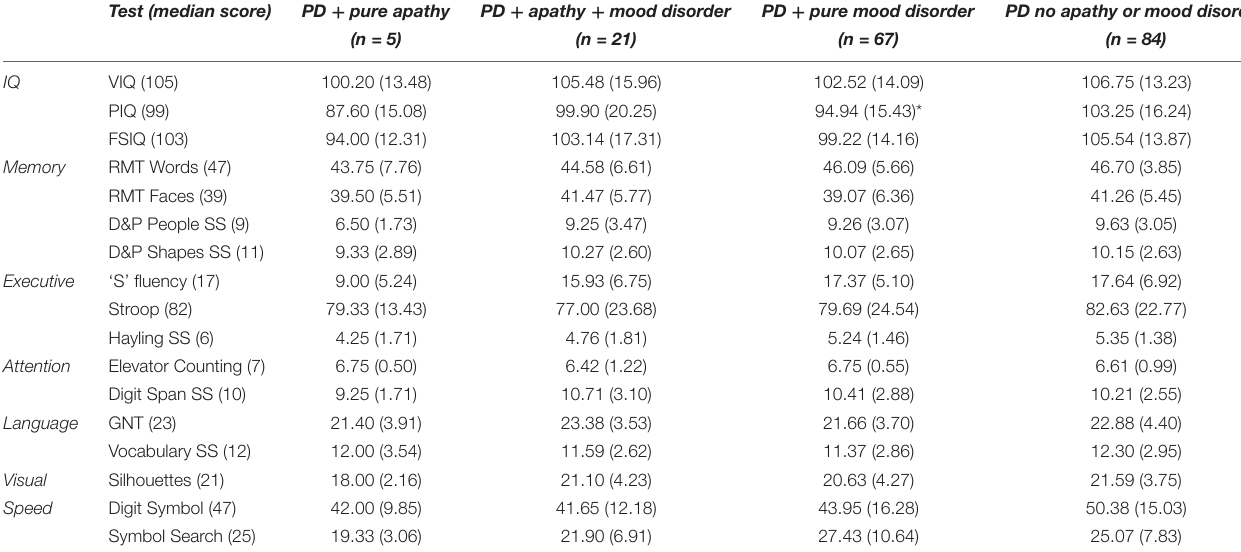
TABLE 3 | PD patient groups’ performance on cognitive assessment [mean (SD)].